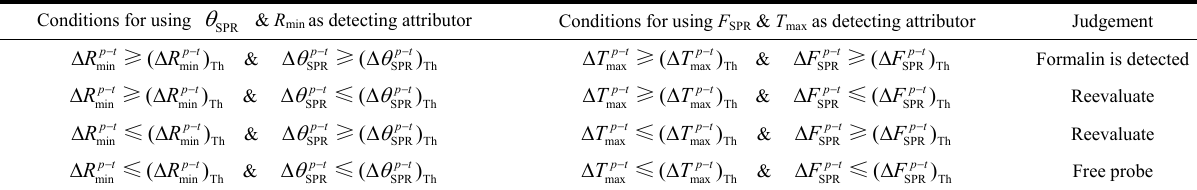
Table 4 Four probable conditions for making decision about successful